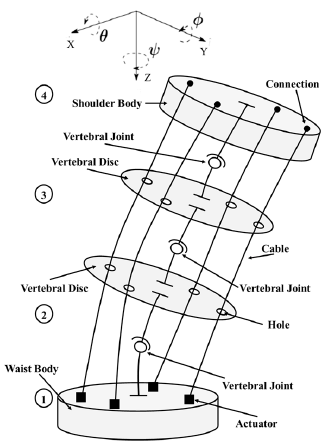
Figure 1. A kinematic design scheme of CAUTO (CAssino hUmanoid TOrso) with a human-like structure.